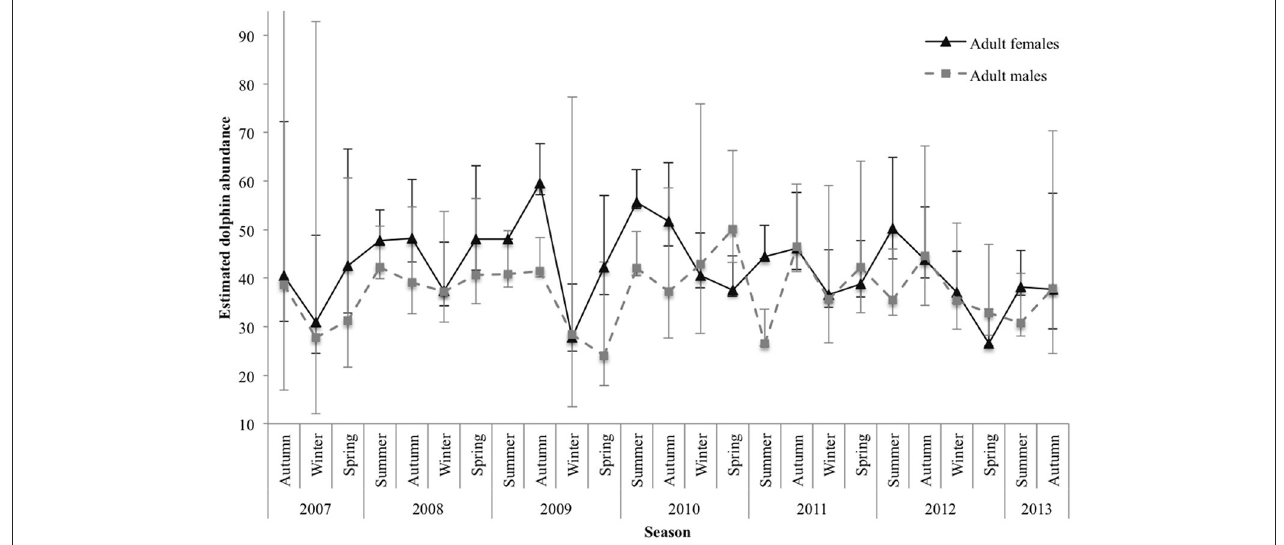
FIGURE 5 | Seasonal abundance estimates for marked ( ˆ N m ) adult female and adult male dolphins. Lines between data points of the seasonal mean have been used for illustrative purposes only; continuity of values is not implied. Vertical lines represent 95% confidence intervals. The upper interval for the initial estimate of adult males was truncated (upper 95% CI 142.42) for display